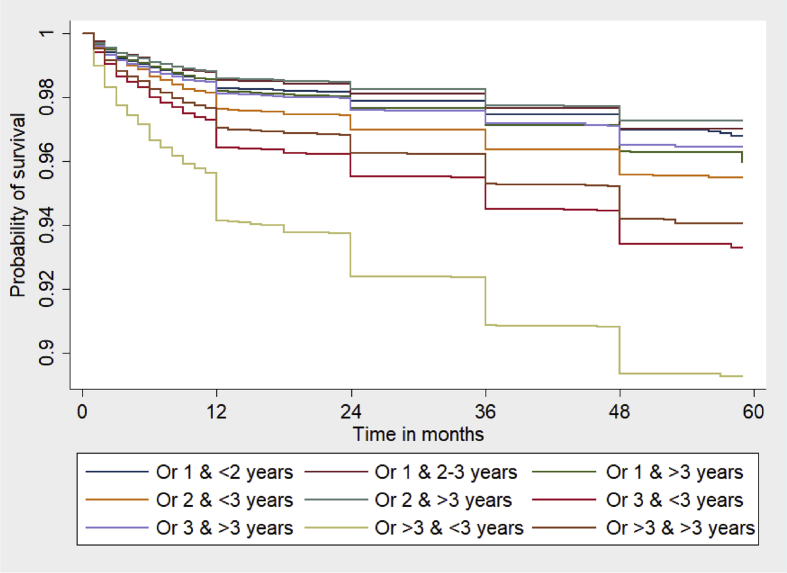
Kaplan–Meier survival estimates of under-five children in India, 2015–16. Or 1 & <2 years = Order 1 & <2 years of IBMFB; Or 1 & 2–3 years = Order 1 & 2–3 Years of IBMFB; Or 1 & >3 years = Order 1 & >3 Years of IBMFB; Or 2 & <3 years = Order 2 & <3 Years of IBBSB; Or 2 & >3 years = Order 2 & >3 Years of IBBSB; Or 3 & <3 years = Order 3 & <3 Years of IBBSB; Or 3 & >3 years = Order 3 & >3 Years of IBBSB; Or >3 & <3 years = Order >3 & <3 Years of IBBSB; Or >3 & >3 years = Order >3 & >3 Years of IBBSB. IBMFB, interval between marriage and first birth; IBBSB, interval between birth and subsequent birth.